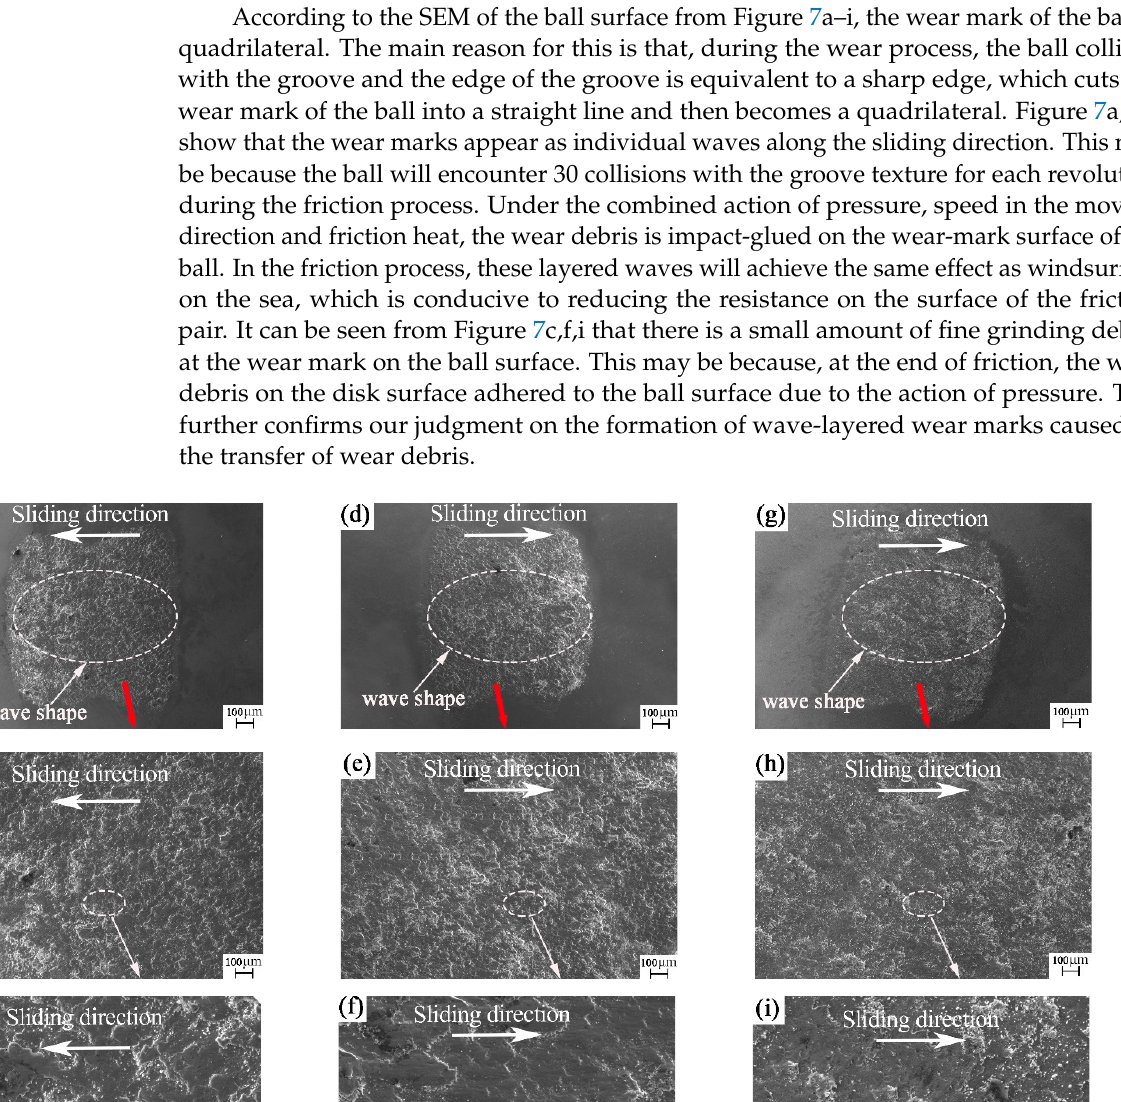
Figure 6. SEM and EDS images of the nanosecond textured worn plates: ( a , b ) nanosecond texture rotation radius 15 mm; ( c , d ) nanosecond texture rotation radius 18 mm; ( e , f ) nanosecond texture rotation radius 22.5 mm.